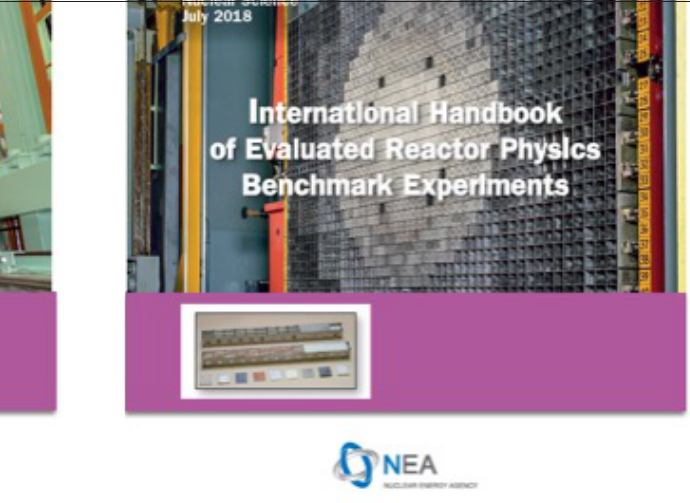
Figure 1. 2018 Edition of the ICSBEP Handbook. Figure 2. 2018 Edition of the IRPhEP